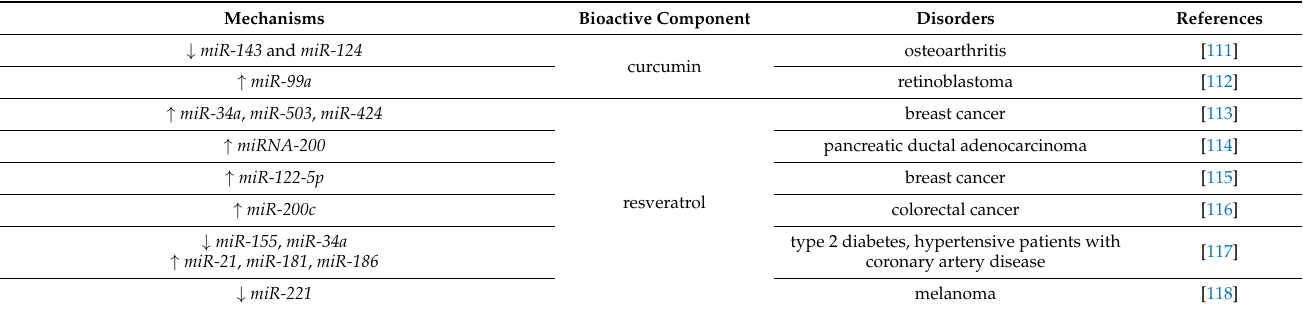
Table 2. Bioactive components of the diet and their role in miRNA level